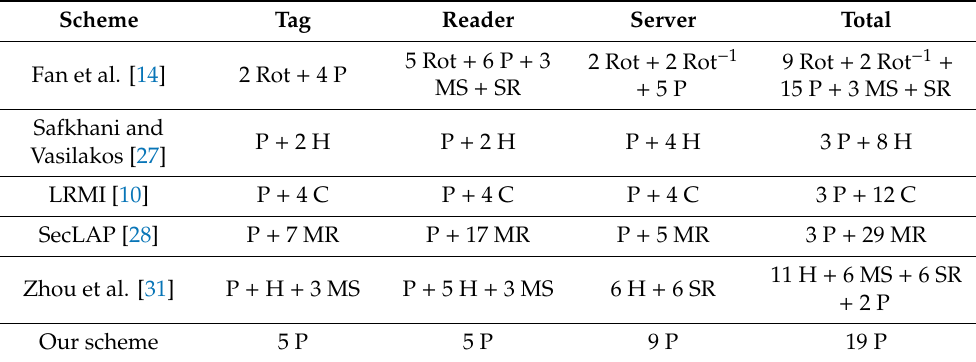
Table 4. Computation cost comparison (in operations).